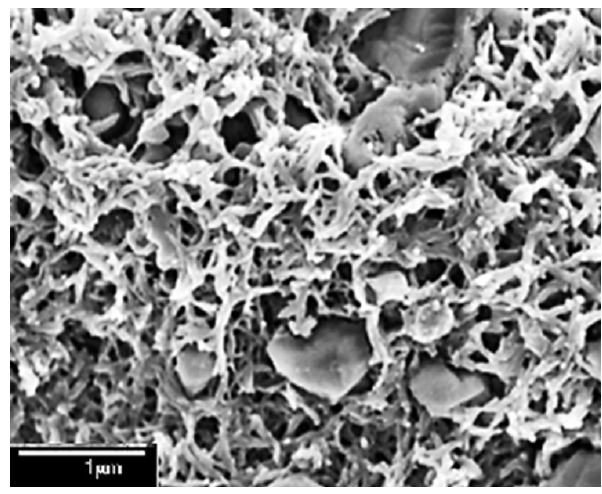
Figure 8. SEM image of the prepared PANI.